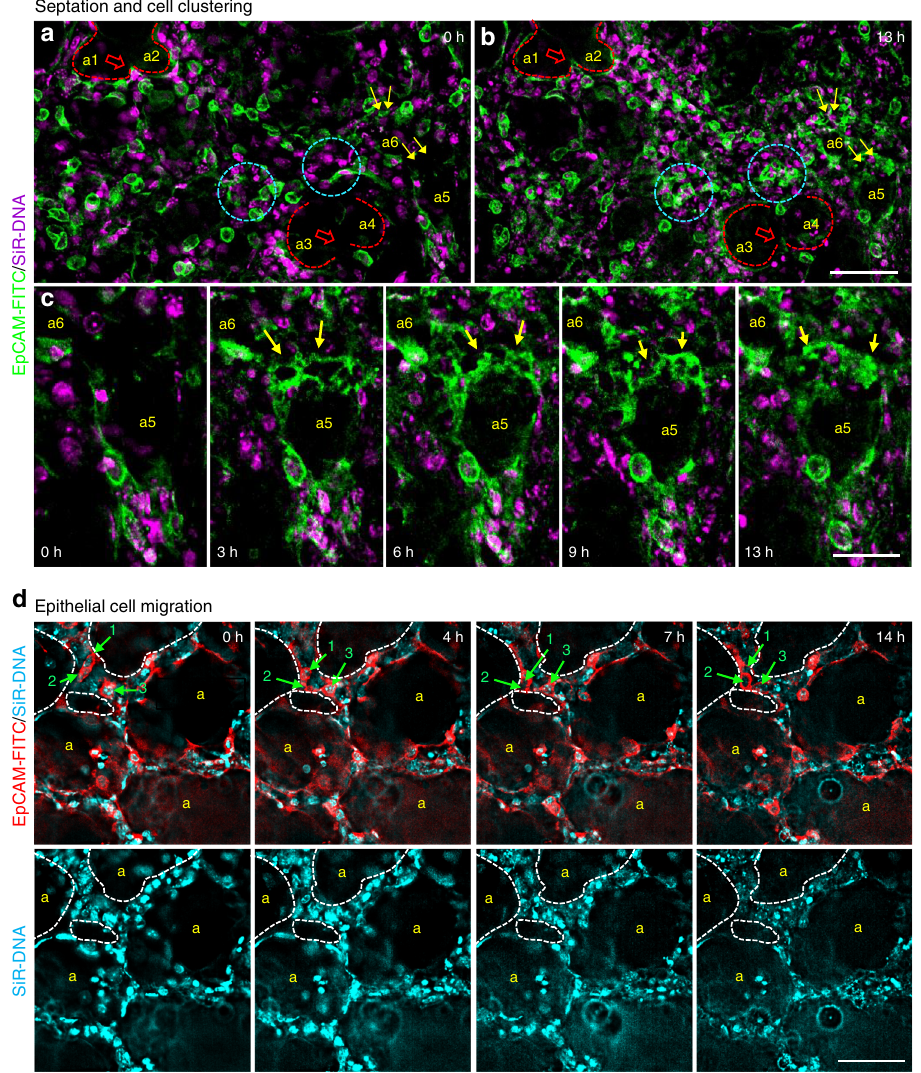
Fig. 3 Septation, cell clustering and cell migration in PCLSi. Deconvolved wide fi eld images of P3 PCLS from 13 h time-lapse video (Supplementary movie 5A and higher magni fi cation 5B, 5Ci) show two examples of septation, i.e., extension of secondary septum into an airspace (dashed red line demarcates airspaces a1/a2 and a3/a4, red boxed arrows point to secondary septa ( a , b ). Epithelial cell clustering, a common feature noted during postnatal alveologenesis, is indicated by blue circles ( a , b ) (Supplementary movie 5A and higher magni fi cation 5D). The images also show EpCAM-FITC (green) labelled alveolar epithelial cell migration (yellow arrows) towards existing airspaces (a5 and a6) ( a – c ). Enlarged still images from 13 h time-lapse video (Supplementary movie 5A higher magni fi cation 5E at 0, 3, 6, 9 and 13 h, show epithelial cell migration (yellow arrows) towards airspace a5 ( c ). Nuclei were labelled with SiR-DNA (magenta). Scale bar = 50 µ m ( a , b ), 25 µ m ( c ). Deconvolved EpCAM-FITC (red)/SiR-DNA (cyan) labelled still images from 14 h time-lapse video (Supplementary movie 6) showing EpCAM positive epithelial cell migration (green arrows) towards alveolar airspace (white dashed lines outline airspaces) in P3 PCLS ( d ). Cells 1 and 2 migrate towards a small airspace (white dashed outline) within the interstitium and meet cell 3 ( d , upper panel). Corresponding images labelled with SiR-DNA only are displayed in d , lower panel. Yellow ‘ a ’ indicates alveolar airspaces. Scale bar = 50 µ